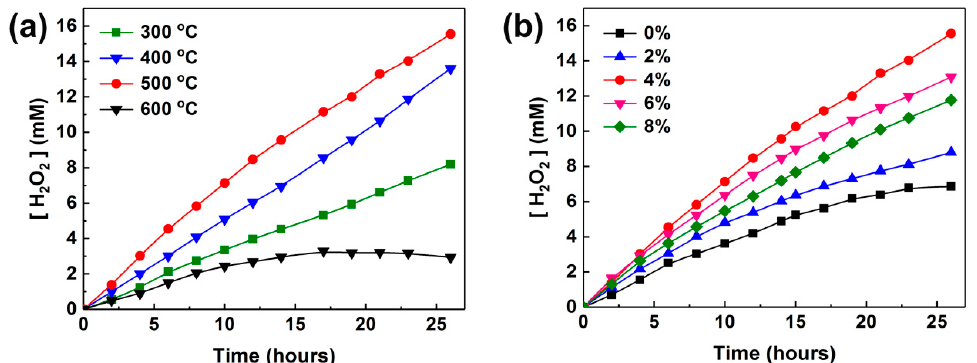
Figure 2. ( a ) Plots of [H 2 O 2 ] under UV-irradiation in the presence of 0.1% Au loaded SnO 2 -TiO 2 (4% SnO 2 modified anatase TiO 2 ) obtained at different sintering temperatures. ( b ) Plots of [H 2 O 2 ] under UV-irradiation in the presence of 0.1% Au loaded SnO 2 -TiO 2 with different Sn/Ti ratios.